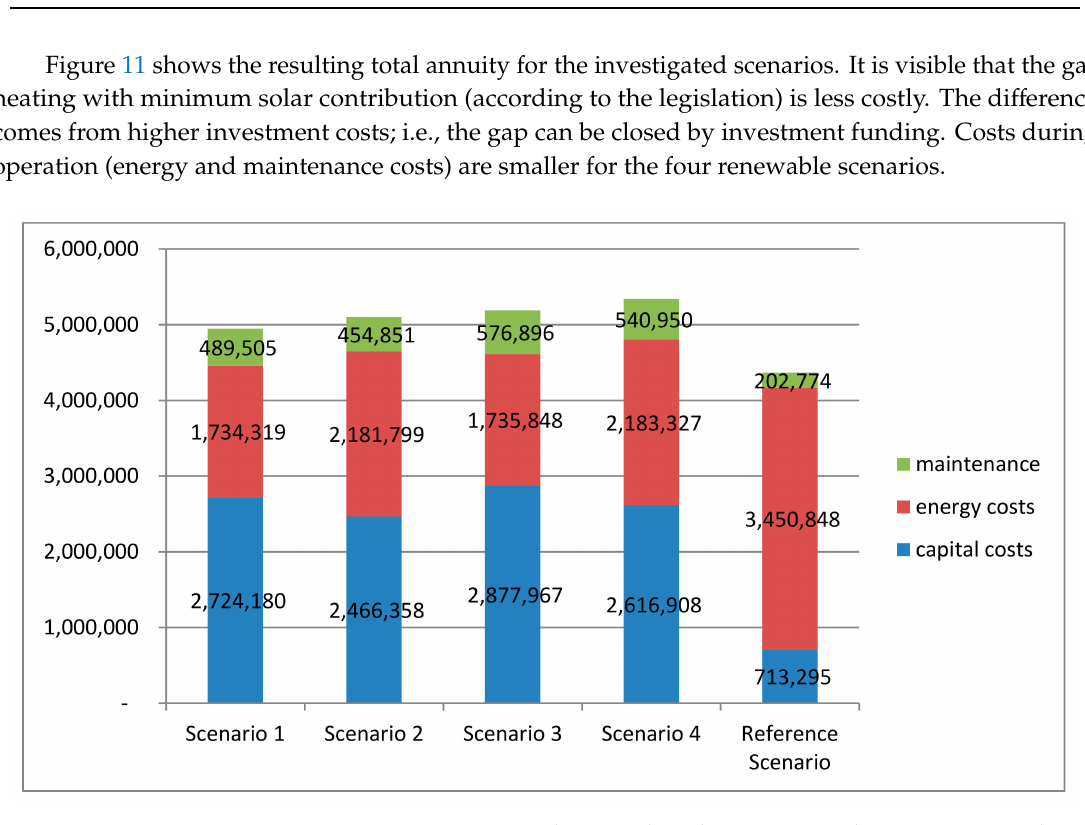
Figure 11. Annuity costs in EUR / a per scenario, distinguishing between capital costs, energy and maintenance